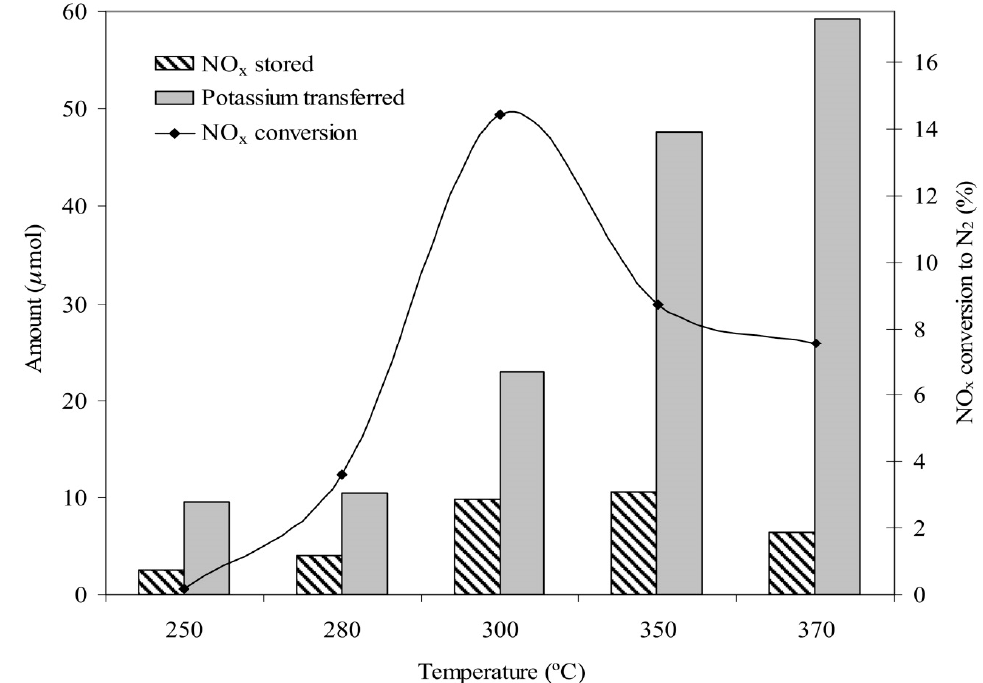
Figure 17. Influence of the reaction temperature on the amount of NO x stored, potassium transferred and on the NO x conversion to N 2 during NO x storage/reduction experiments. Lean phase (NO/C 3 H 6 /O 2 :1000 ppm/1000 ppm/5% O 2 ), 6 min of duration, V cell = − 1.5 V. Rich phase (NO/C 3 H 6 /O 2 :1000 ppm/1000 ppm/0.5% O 2 ), 5 min of duration, V cell = 3V. Data was acquired in a Pt/(K) β Al 2 O 3 /Au galvanic cell (Reprinted with permission from Ref. [103]; Copyright 2011, Elsevier).